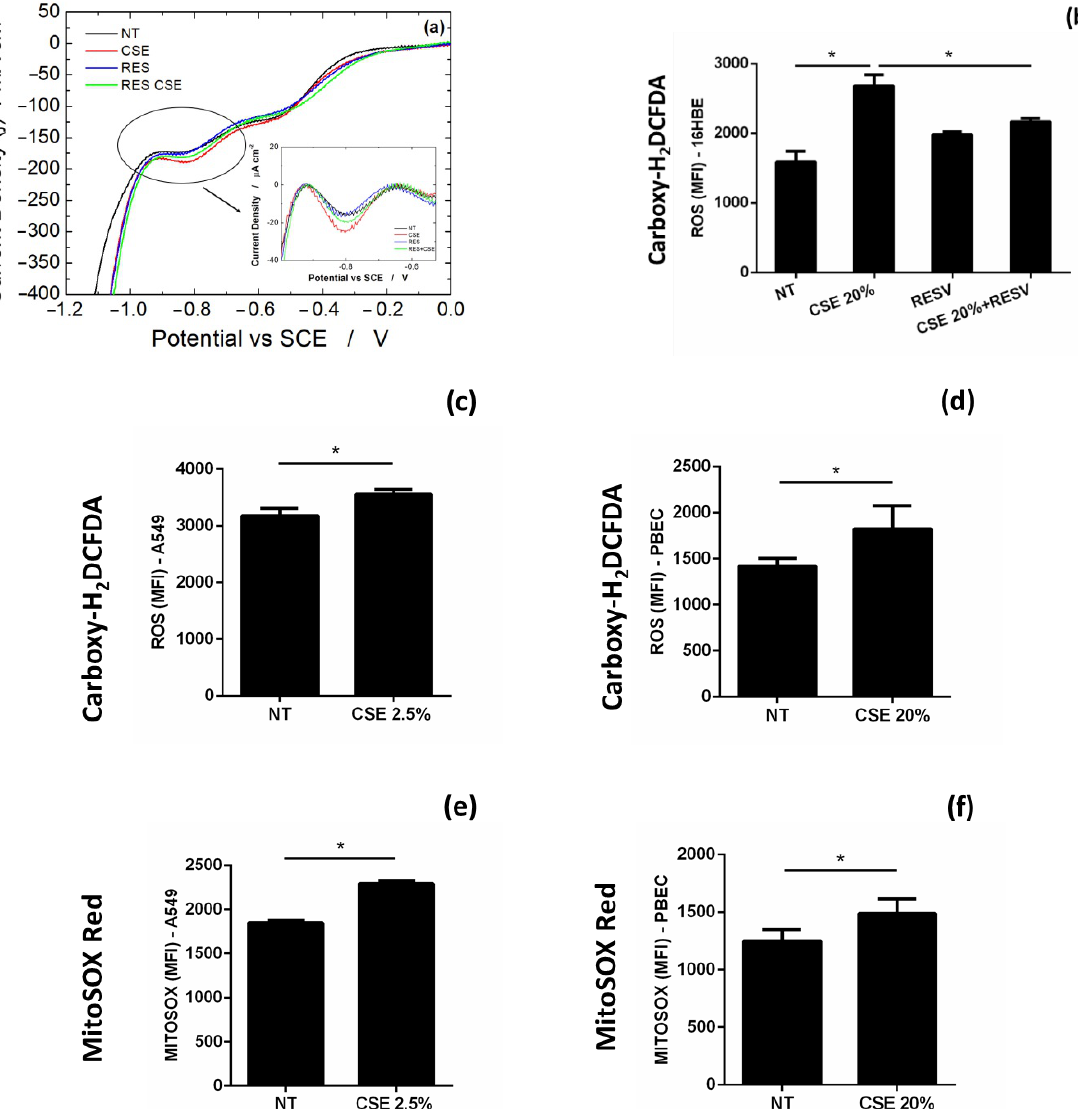
Figure 7. ( a ) LSV experiments with 16HBE cell line and ROS detection by flow cytometry using Carboxy-H2DCFDA probe in ( b ) 16HBE, ( c ) A549, and ( d ) PBEC and using Mitosox Red probe in ( e ) A549, and ( f ) PBEC. In the inset of ( a ) the LSV curves after baseline subtraction. * p value < 0.05 Unpaired t -test (N = 3).